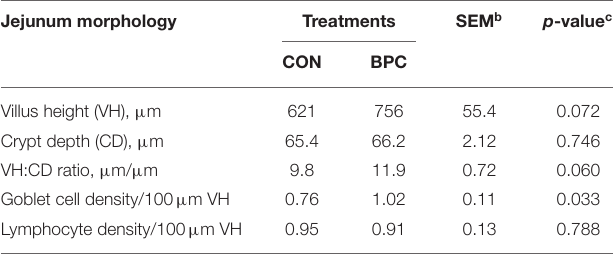
TABLE 2 | Effects of BPC supplementation during gestation of hyperprolific sows on jejunal histomorphology of neonate piglets a . Jejunum